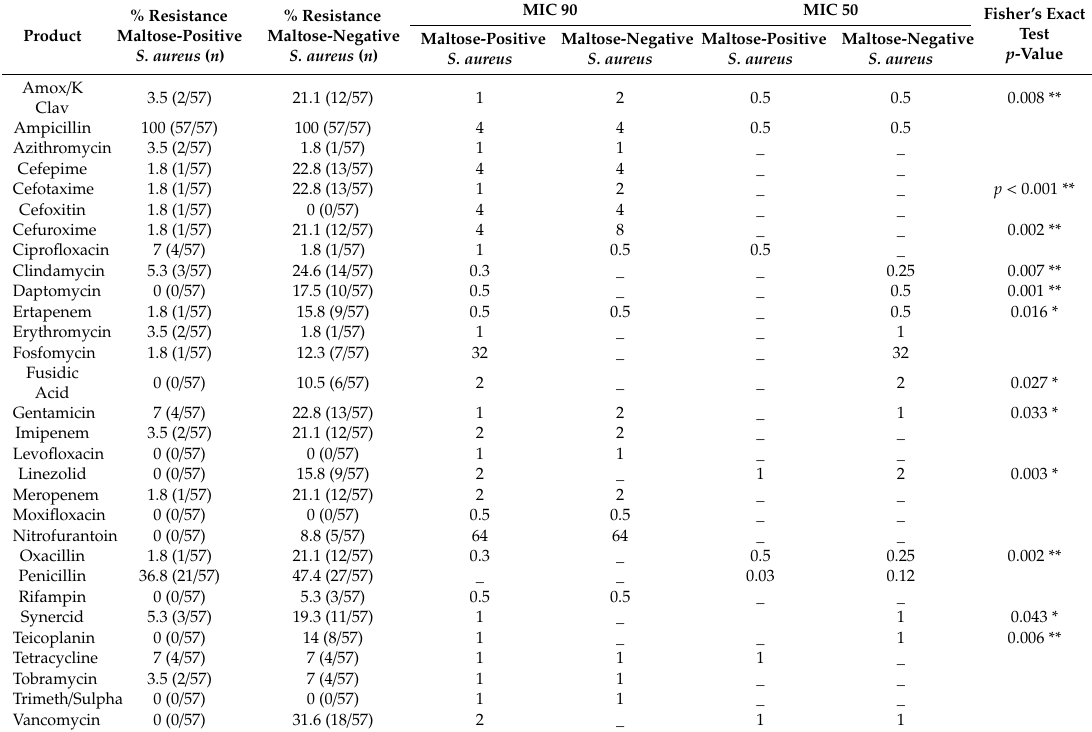
Table 2. The minimum inhibitory concentrations (MIC) 90 and MIC 50 for maltose-positive and maltose-negative S.